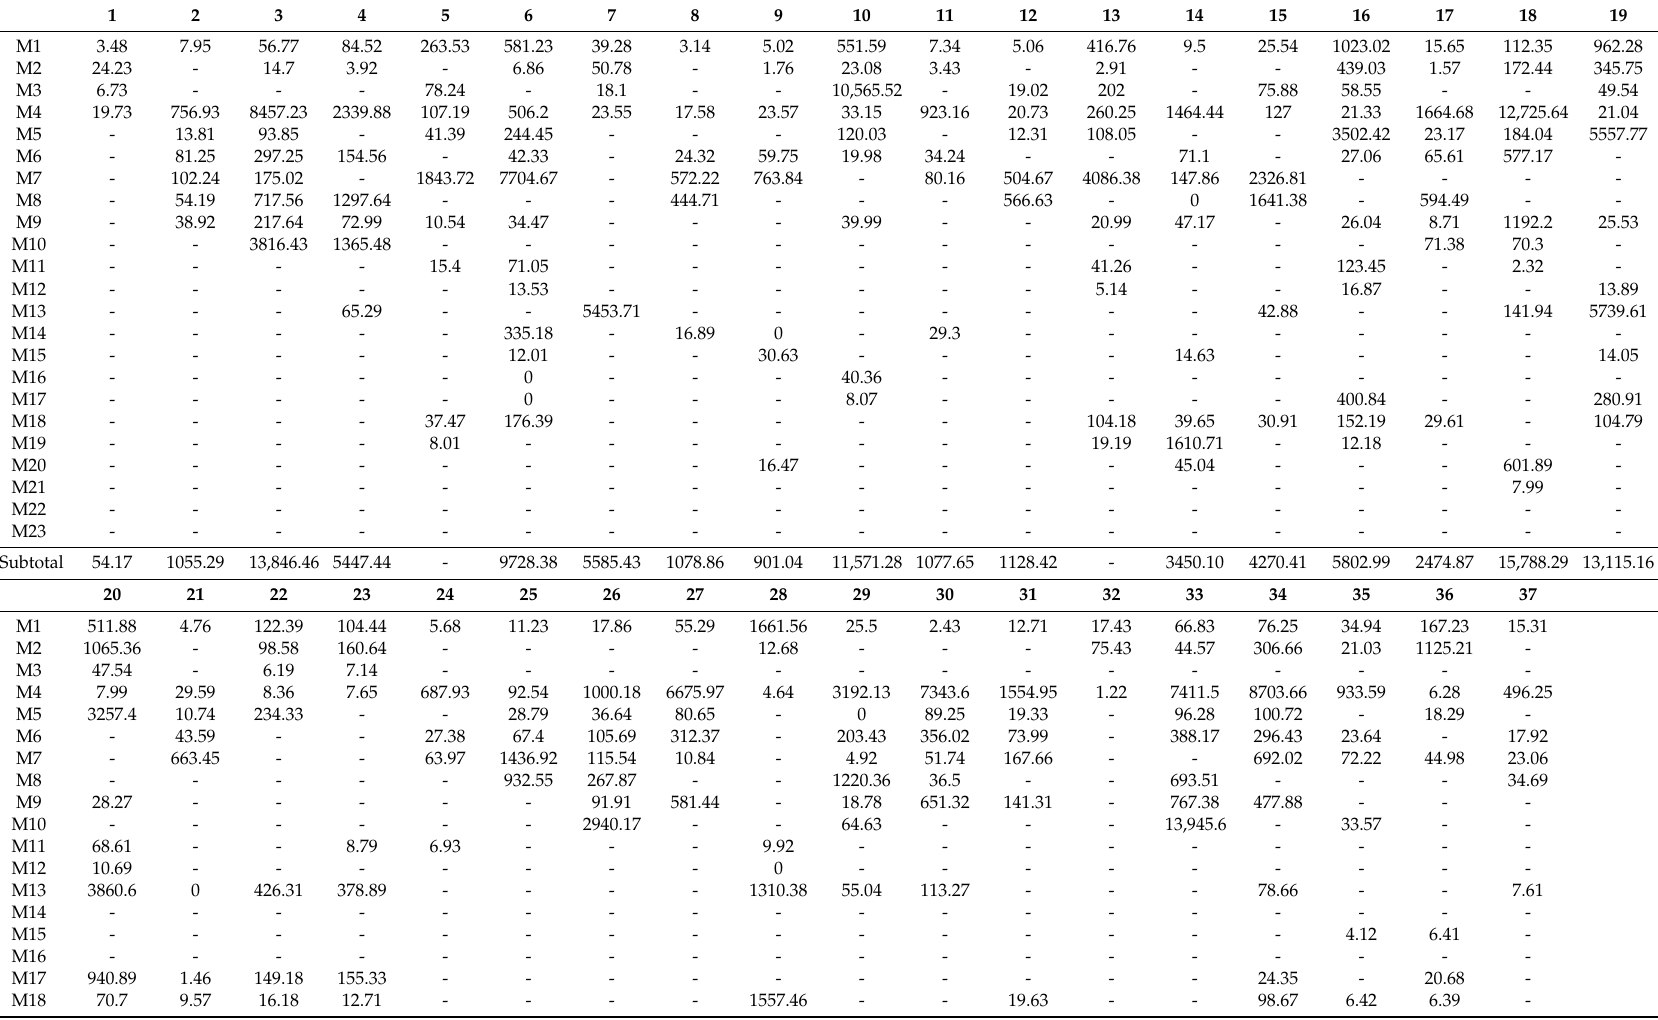
Table 2. Concentrations ( µ g/kg fresh weight (FW) equivalent of nonyl acetate) of volatile monoterpenes in 37 mango